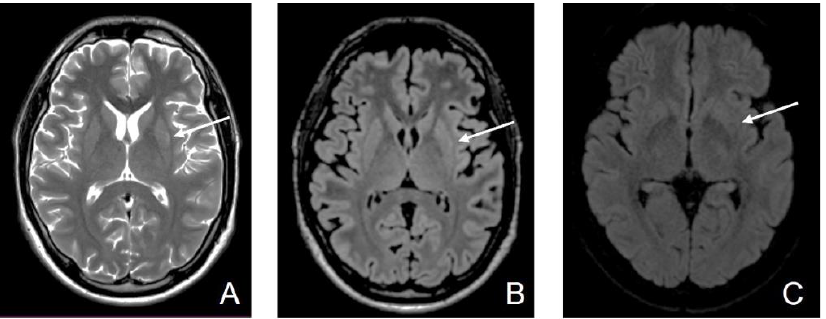
Figure 5. Fiveth MRI (D63). ( A ) Axial T2-wi; ( B ) Axial FLAIR: normal signal intensity with only a discrete band of peripheral high signal intensity T2 wi/FLAIR in bilateral putamen; ( C ) Axial DWI: there is no more restricted diffusion in the lenticular nucleus (white arrow).